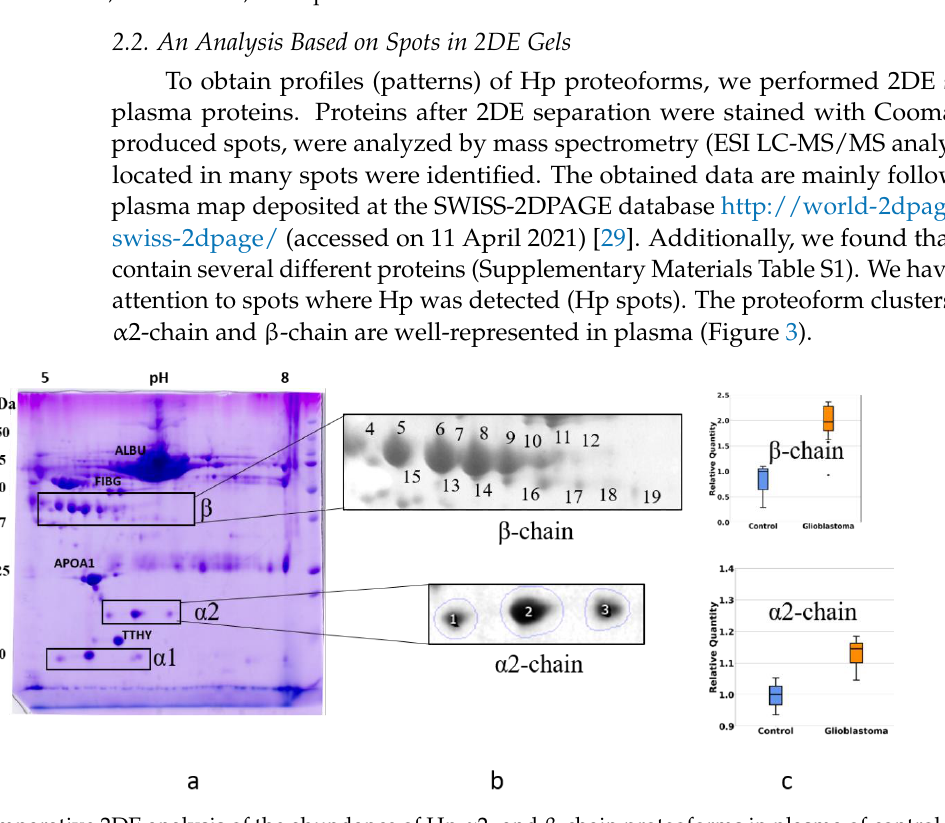
Figure 2. Western blotting of plasma samples. The duplicates of the gels shown in Figure 1 were tested using Ab against α 2-chain and β -chain ( a – c ). Intensity statistical analysis of the bands of α 2-chain and β -chain ( d , e ). GBM samples are marked as G, control—as C, cancer—as T, acute phase—as A.